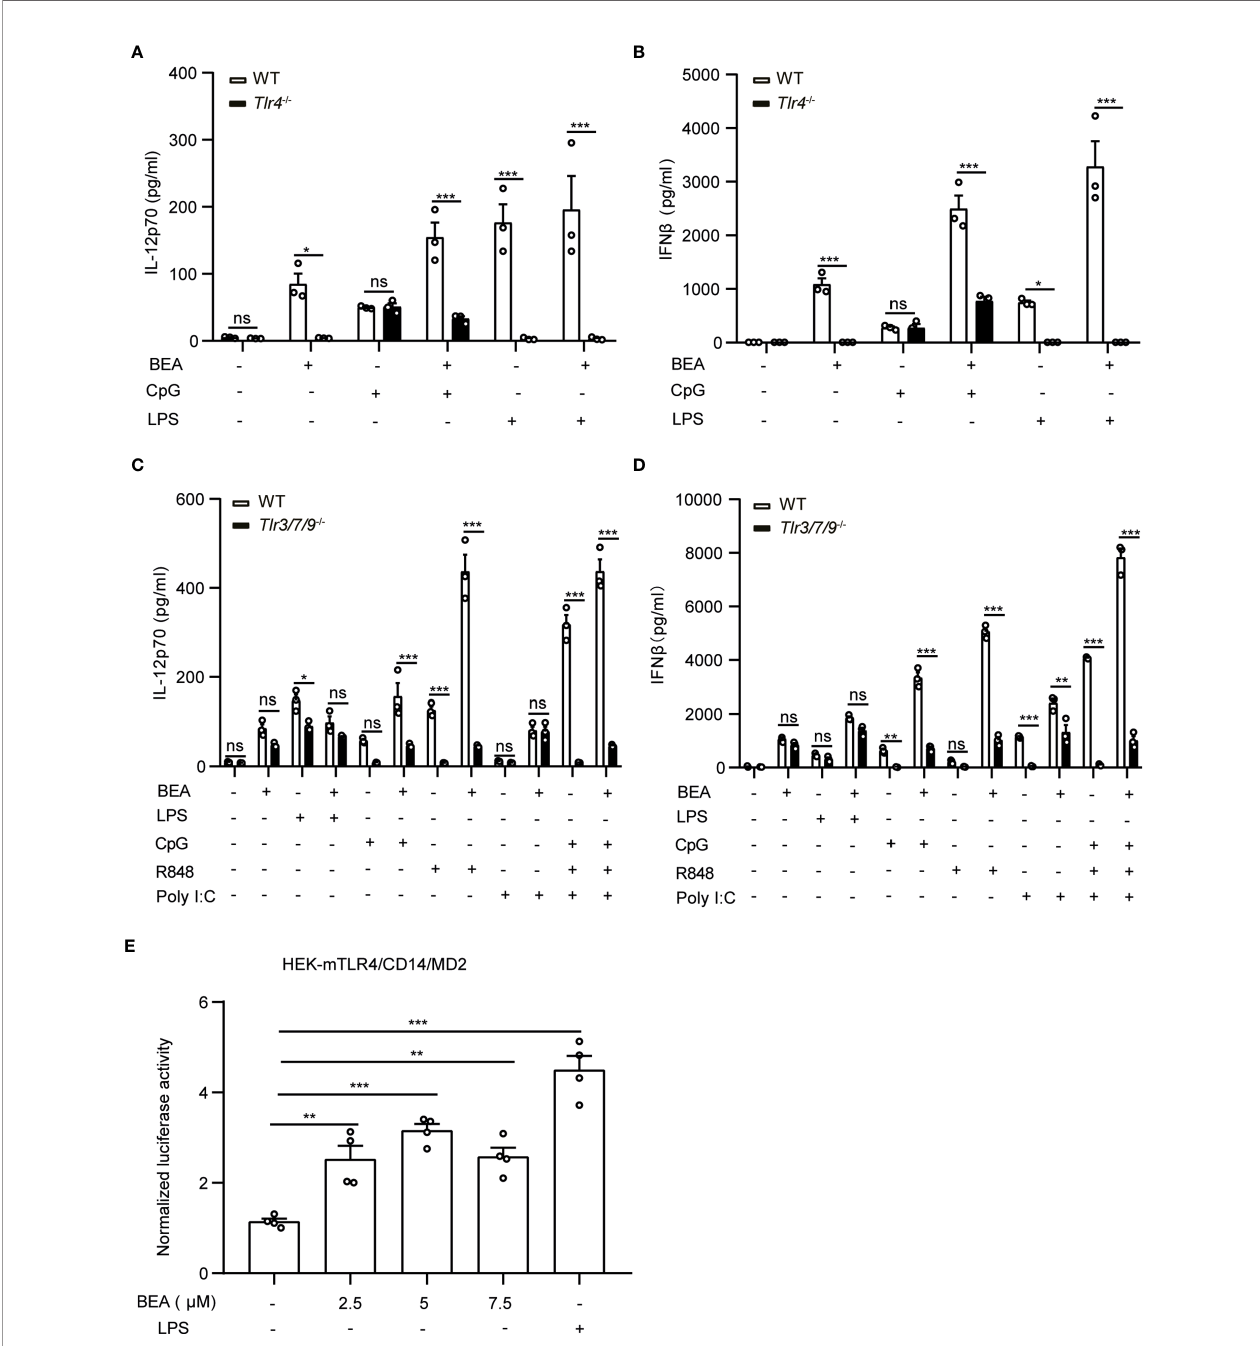
FIGURE 5 | BEA activates BMDCs via TLR4. (A, B) 10 6 BMDCs derived from WT and Tlr4 -/- mice were stimulated with 5 µM BEA with or without LPS (10 ng/ml) and CpG (0.5 m M). After 24 hours of stimulation, supernatants were analyzed for IL-12p70 and IFN b by ELISA. Results shown are representative of two independent experiments using cells from 3 mice per group (n=3) (C, D) 1x10 6 BMDCs derived from WT and Tlr3/7/9 -/- mice were stimulated with 5 µM BEA with or without LPS (10 ng/ml), CpG (0.5 m M), R848 (1 m g/ml), or Poly I:C (25 ng/ml). After 24 hours of stimulation, supernatants were analyzed for IL-12p70 and IFN b by ELISA. Results shown are representative of two independent experiments using cells from 3 mice per group (n=3). Data in A, B, C and D are presented as mean ± SEM and analyzed by two-way ANOVA with Sidak ’ s multiple comparisons test. (E) 3.5x10 4 HEK-293 cells stably expressing mTLR4/CD14/MD2 were transiently transfected with fi re fl y luciferase NF- k B reporter and Renilla plasmids. After 24 hours, transfected HEK-293 were treated with indicated concentrations of BEA and LPS (1 m g/ml) as positive control and induction of NF- k B was determined by luciferase activity. Results shown are representative of three independent experiments in quadruplicates (n=4). Data are presented as mean ± SEM and analyzed by one-way ANOVA with Dunnett ’ s multiple comparisons test. *p<0.05, **p<0.01, ***p<0.001, ns, not signi fi